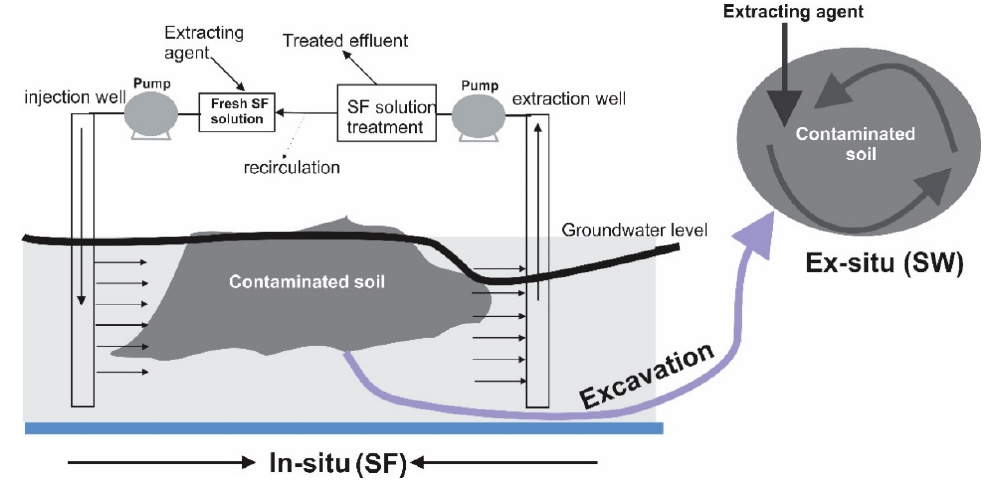
Figure 2. Scheme of a typical soil flushing and SW processes. Adapted from [2].